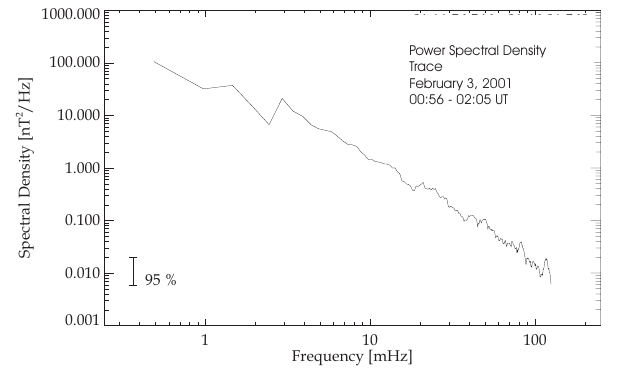
Fig. 9. Trace of the frequency power spectral density matrix deter- mined using data displayed in Fig. 8.